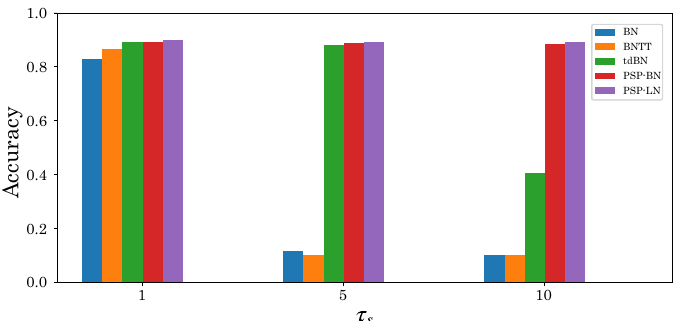
Figure 11. Accuracy comparison of F-MNIST dataset with respect to changing hyperparameter τ s ( = 1,5,10 ). { }